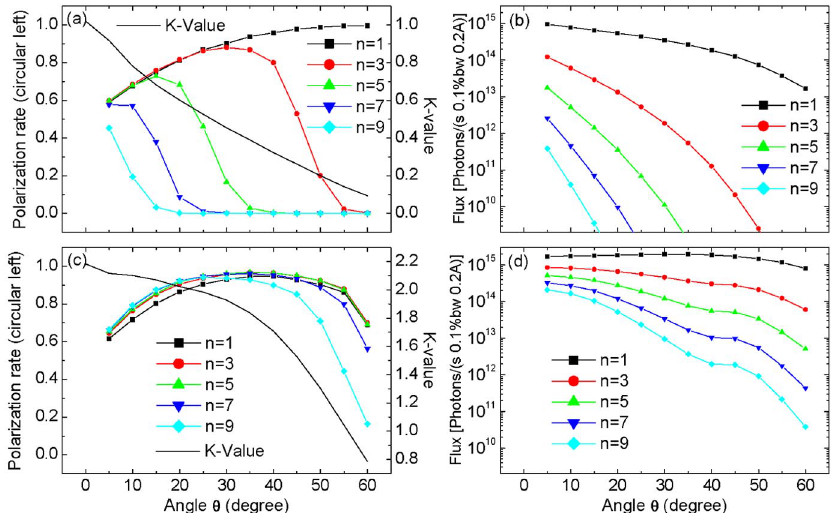
FIG. 8. (Color) Polarization rate and photon energy as functions of rotation angle (cid:6) for (a) and (b) the staggered undulator, whose photon flux is calculated at the maximum deflection K at each rotation angle with (cid:12) undulator, whose photon flux is calculated at the maximum deflection value K at each rotation angle with (cid:12) q (cid:2)(cid:2)(cid:2)(cid:2)(cid:2)(cid:2)(cid:2)(cid:2)(cid:2)(cid:2)(cid:2)(cid:2)(cid:2)(cid:2)(cid:2)(cid:2)(cid:2)(cid:2)(cid:2) (cid:6) K 2 K 2 . deflection parameter is K (cid:1) x z